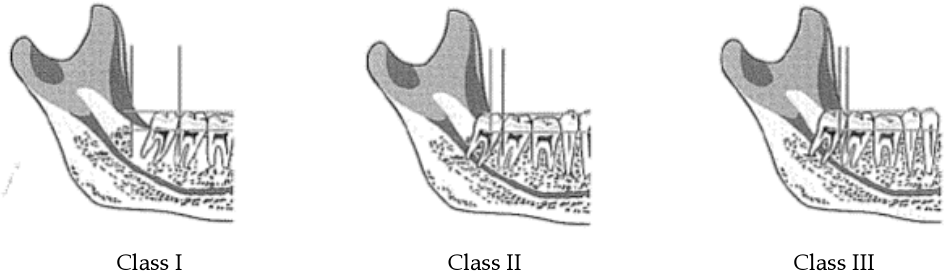
Figure 1. Pell and Gregory classification regarding the space distal to the second molar in relation to the difficulty of the third molar extraction. ( Class I ): the space is sufficient for the third molar eruption and the extraction is easy. ( Class II ): the space is not enough for a complete eruption and the extraction is more difficult. ( Class III ): the third molar is completely impacted, and the extraction is the most difficult.